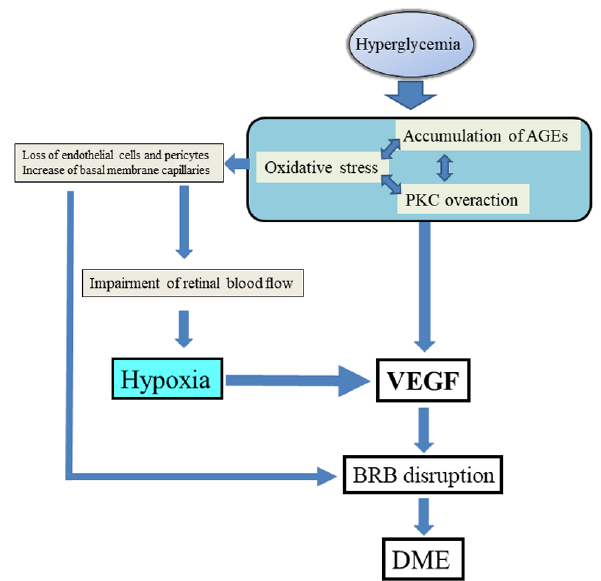
Figure 1. Hypothesized pathogenesis of diabetic macular edema. Hyperglycemia induces oxidative stress and, if maintained over time, produces advanced glycation end-products (AGEs). The accumulation of any AGEs increases the activity of protein kinase C (PKC), which in turn causes upregulation of various factors, including vascular endothelial growth factor (VEGF). A loss of endothelial cells and pericytes and increase of basal membrane capillaries result in impairment of retinal blood flow. These events cause retinal hypoxia and increase vascular permeability, leading in turn to further increased production of VEGF or macular edema or both. Abbreviations: BRB, blood-retina barrier; DME, diabetic macular